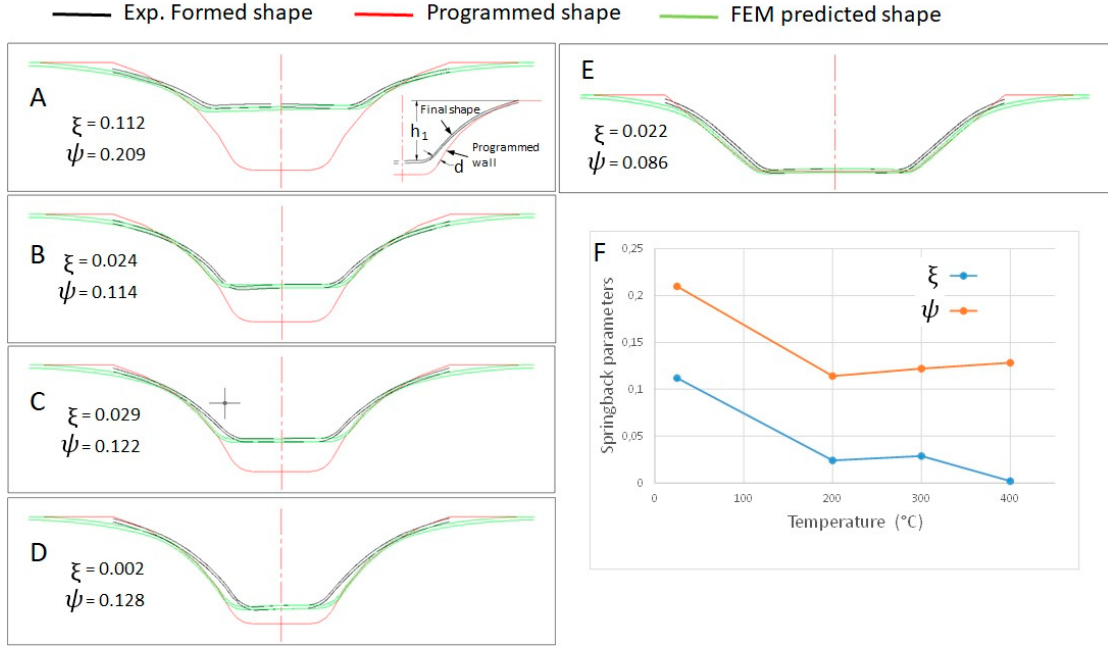
Figure 12. Springback ( A ). Room temperature. ( B ) 200 °C. ( C ) 300 °C. ( D ) 400 °C. ( E ) 400 °C (constant wall angle). ( F ) x and ψ springback parameters for cases (A) to